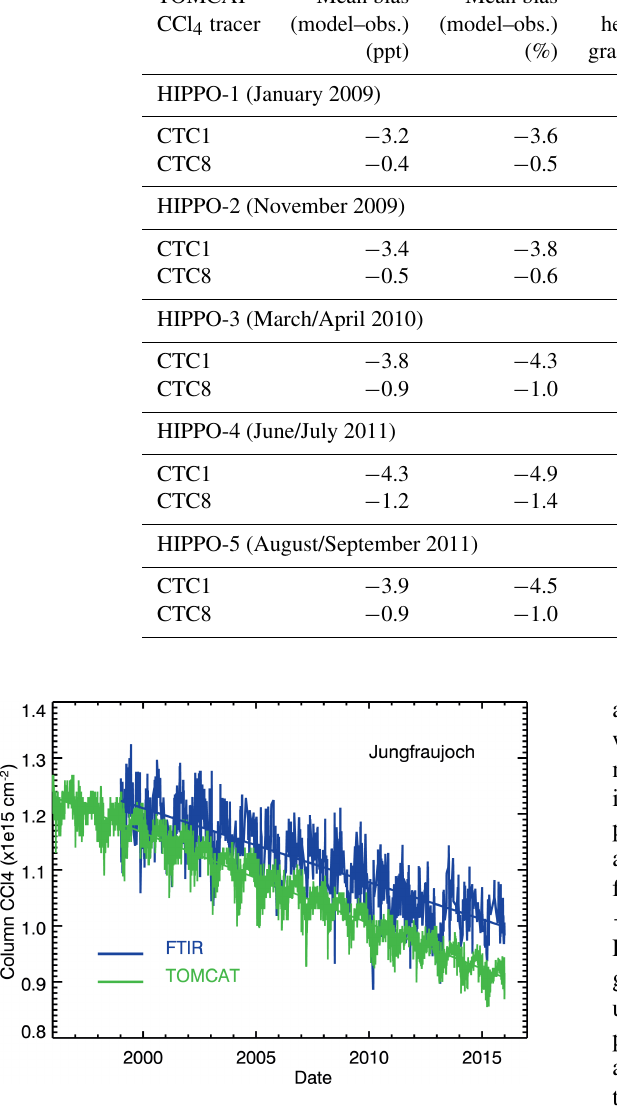
Figure 3. Time series of total column CCl 4 ( × 10 15 moleculescm − 2 ) at the Jungfraujoch NDACC sta- tion, Switzerland (46.5 ◦ N, 8 ◦ E) (blue line). The observations have been scaled by 0.9 to account for a possible high bias in the CCl 4 retrieved columns (see Sect. 3.2). Also shown are results from model control tracer CTC1 (green line). The straight lines are the linear fits to the observations and model